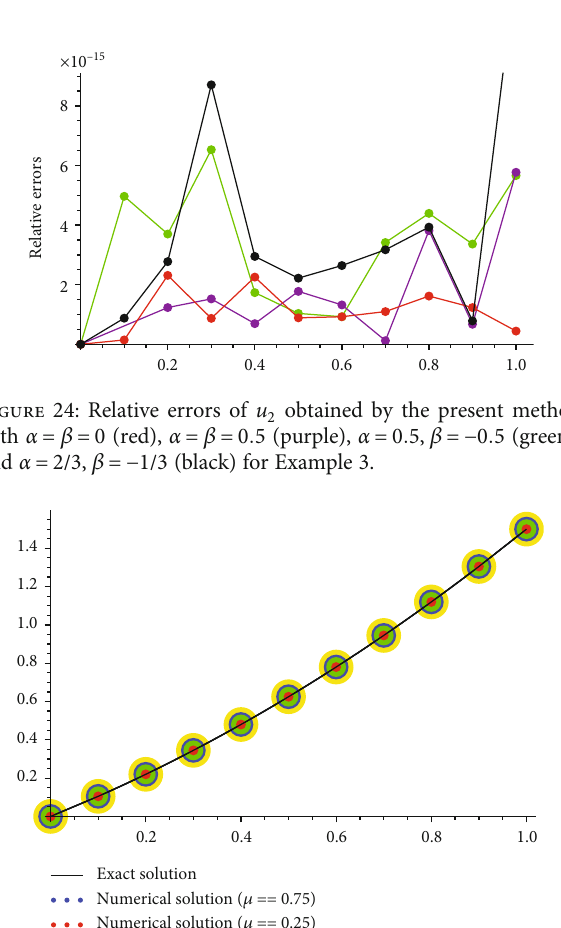
Figure 25: The numerical solution of u 1 obtained by the present method with μ = 0 : 75,0 : 5,0 : 25,1 and exact solutions for Example 3.